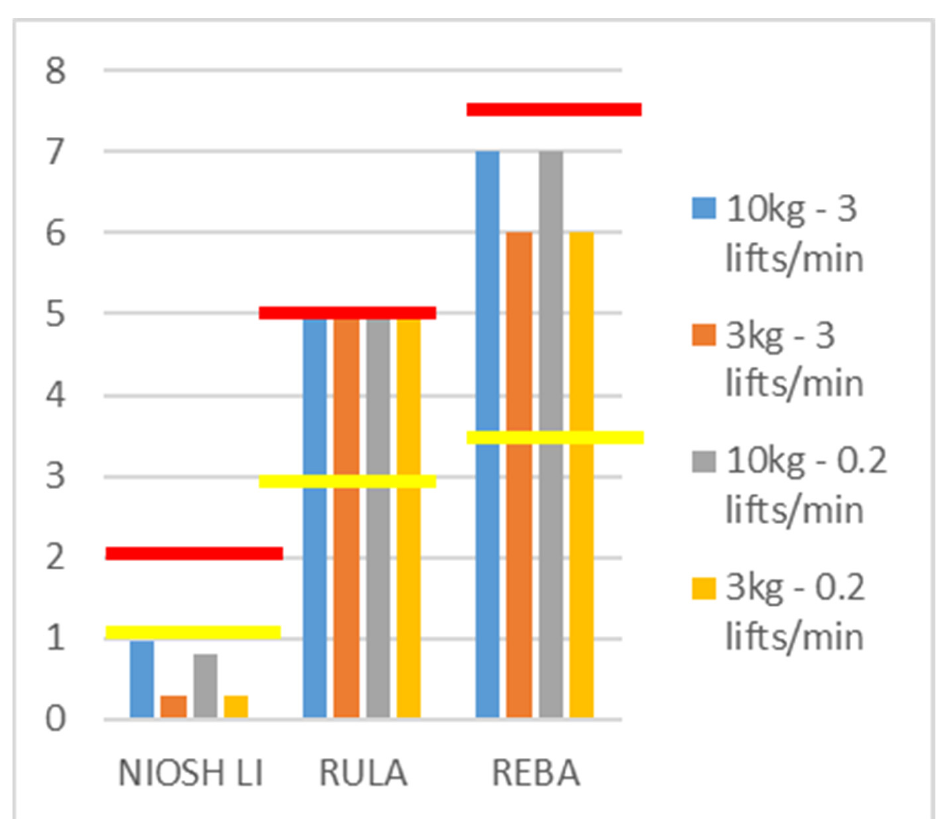
Figure 4. NIOSH Lifting Index, RULA, and REBA scores estimated for the different working condi- tions. Values below the yellow line are low risk, values between the yellow and red line are medium risk, and values above red line are high risk, according to the specific guidelines.